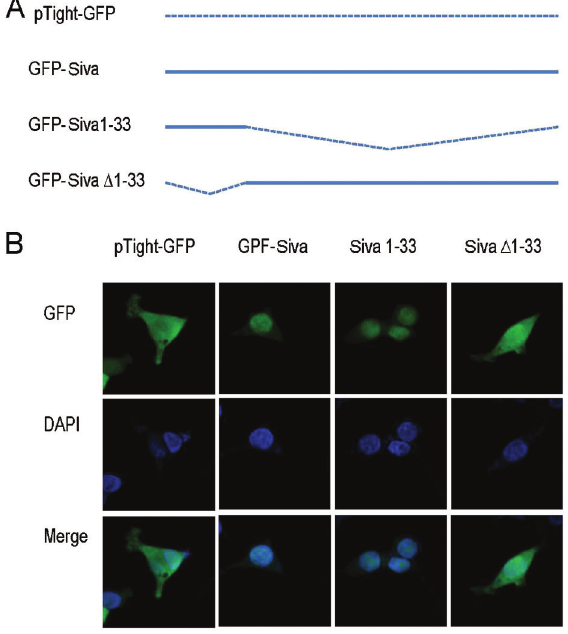
Figure 2. N-terminal amino acid residues 1-33 were sufficient for nuclear localization. Confocal laser scanning microscopy of 293T cells transfected with green fluorescent protein (GFP), GFP-Siva, GFP-Siva1-33, GFP-Siva D 1-33, and counter-stained with DAPI to show the location of the nuclear